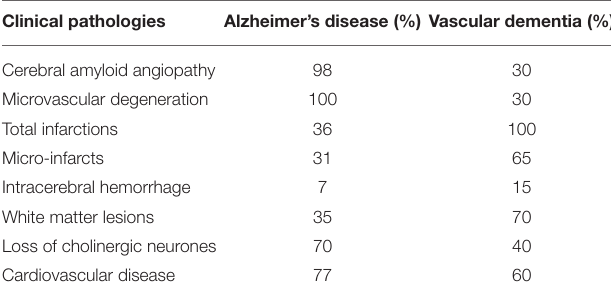
TABLE 2 | Pathologies associated to both Alzheimer’s disease and vascular dementia. Clinical